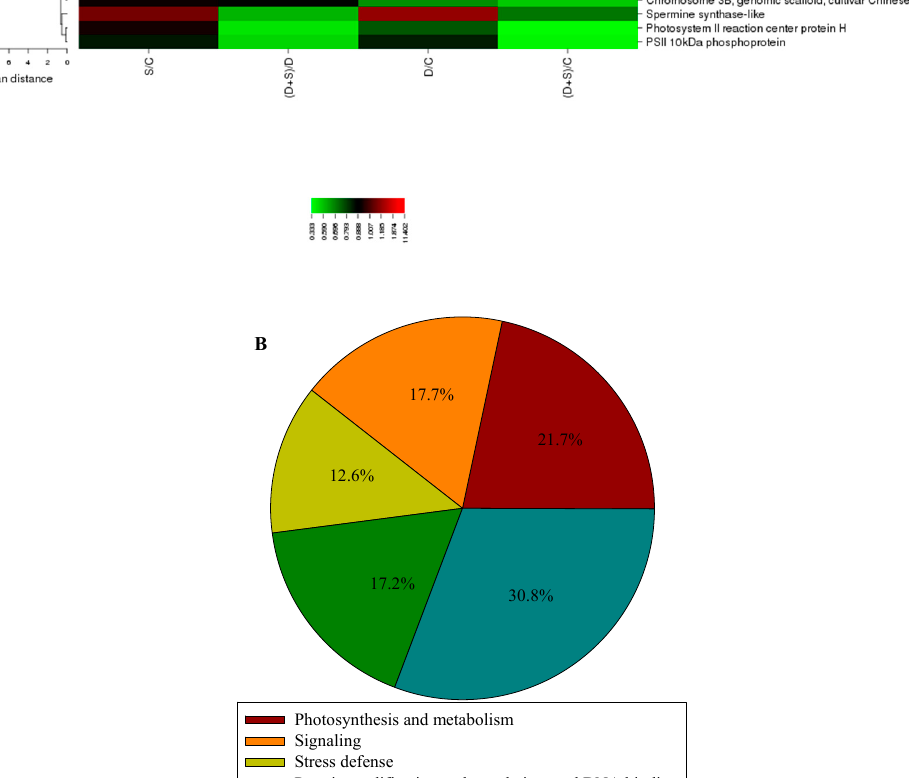
Photosynthesis and metabolism Signaling